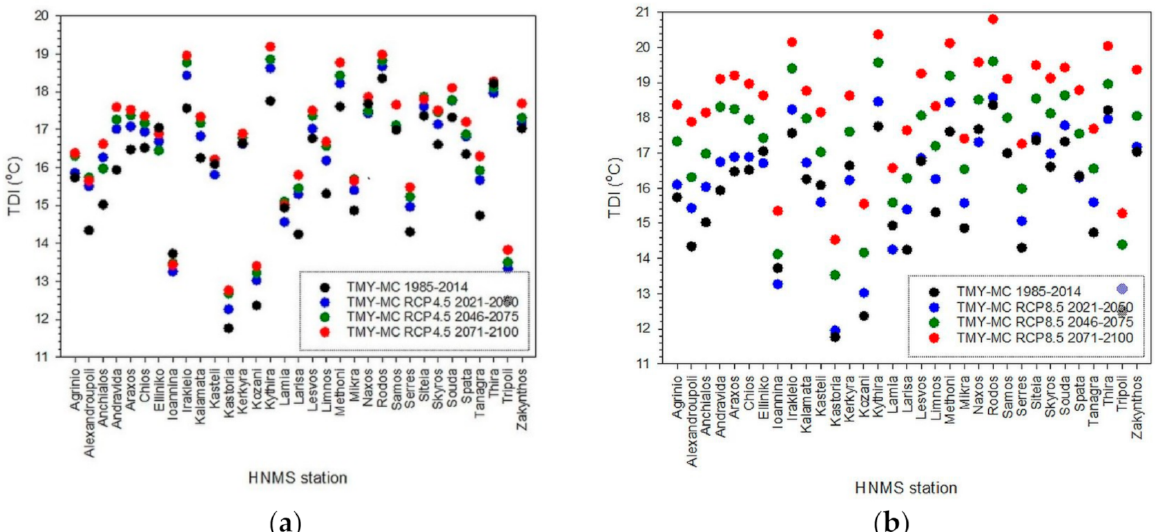
Figure 2. Annual mean TDI values for all HNMS sites (in alphabetical order) as derived from the typical meteorological years -meteorology-climatology (TMYs-MC) during the historical period of 1985–2014 and the future epochs of 2021–2050, 2046–2075, 2071–2100 under the ( a ) representative concentration pathway (RCP) 4.5 and ( b ) RCP 8.5 Intergovernmental Panel for Climate Change (IPCC) scenarios.